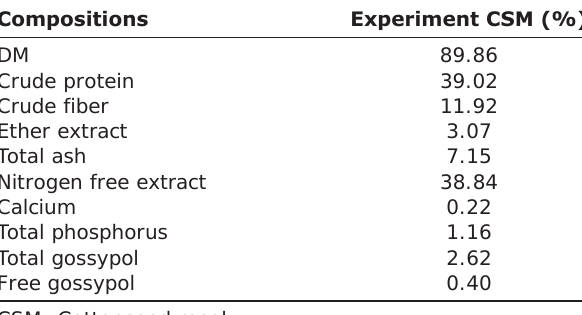
Table-1: Proximate principles (percent on DM basis), mineral and gossypol content of experiment